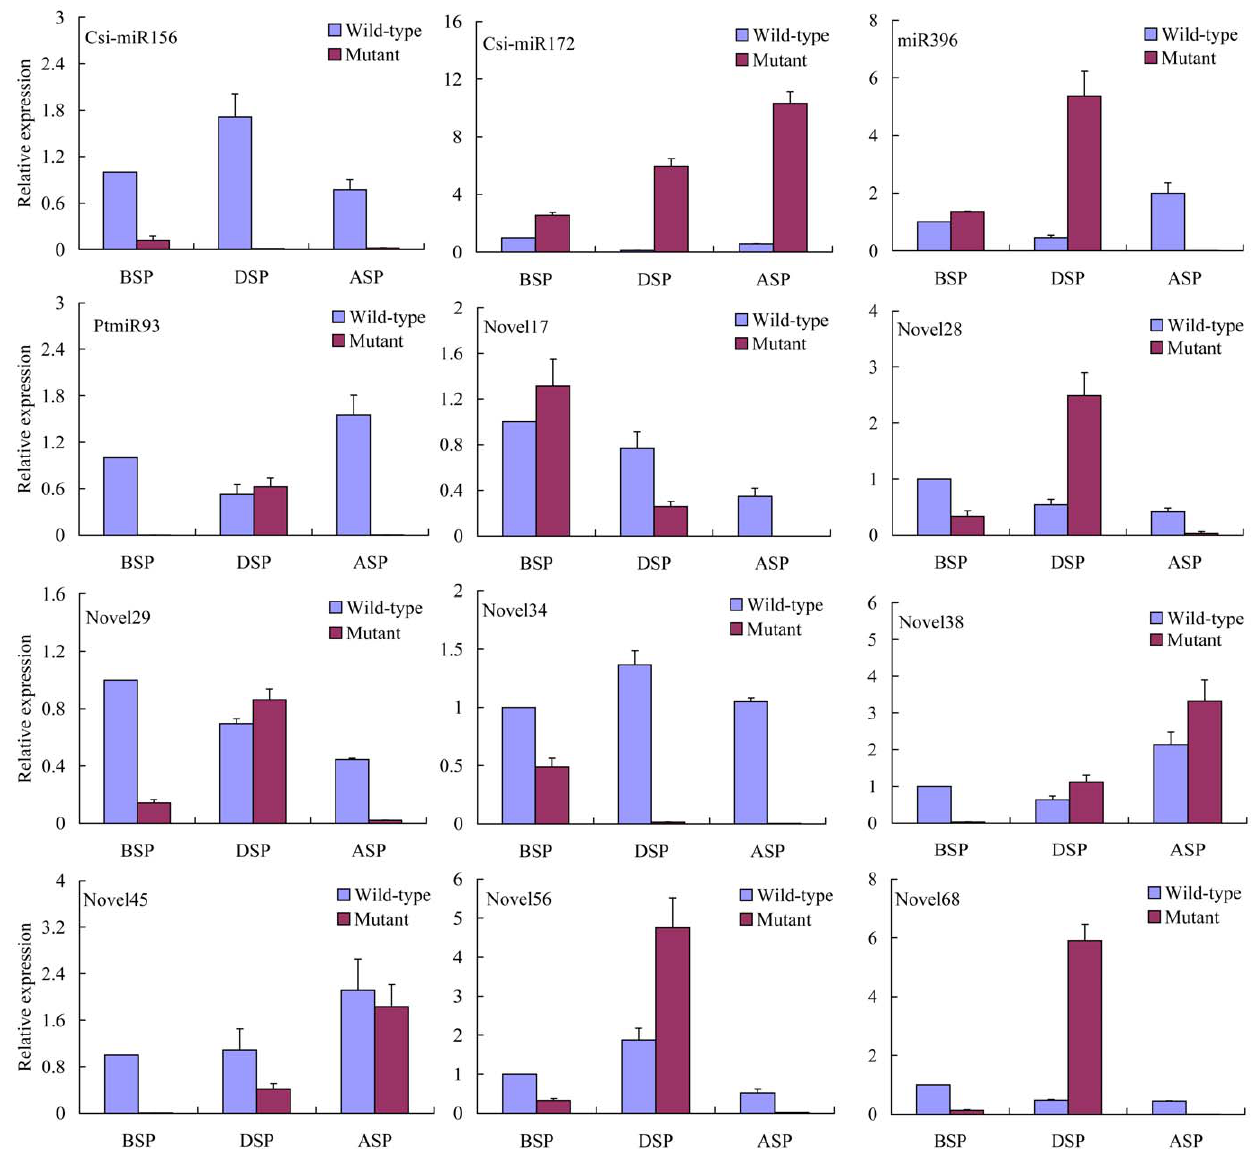
Figure 8. The expression pattern of conserved and novel miRNAs during self pruning. The relative quantities of 12 miRNAs during floral transition in spring shoots of both the MT and the WT were investigated by real-time PCR. b -actin was used as a housekeeping control. Real-time PCR experiments were conducted using the primers displayed in Supporting Table 1. BSP: 15 days before self-pruning; DSP: during self-pruning; ASP: 20 days after